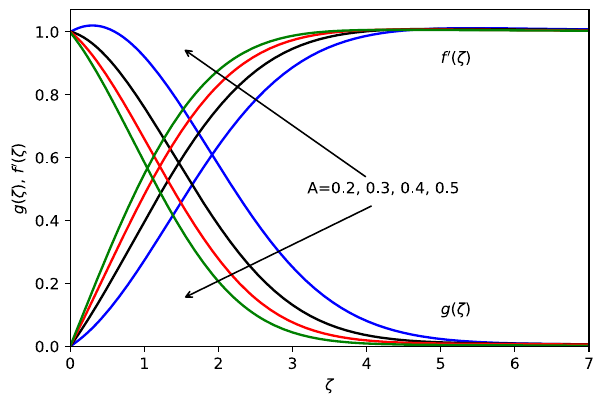
Fig. 3 f � ( 𝜁 ) and g ( 𝜁 ) against